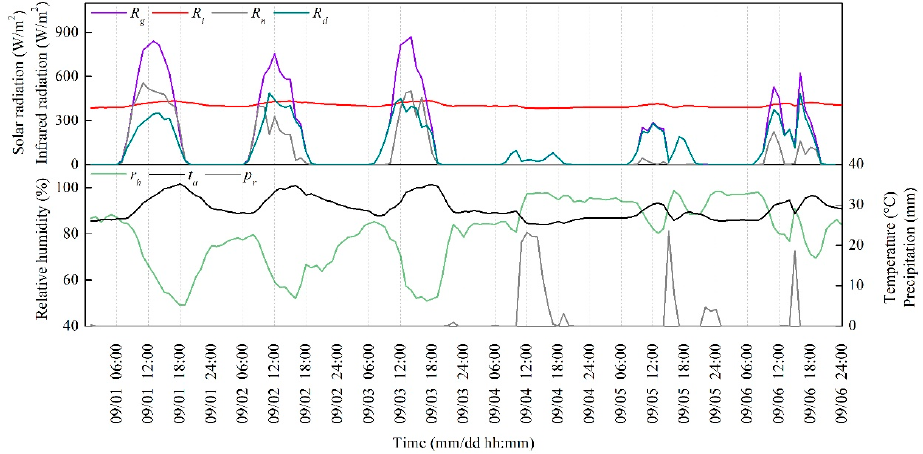
Figure 4. Meteorological data in the non-air-conditioning experimental conditions. R g : global horizontal solar radiation; R i : horizontal infrared radiation intensity from the sky; R n : direct normal solar radiation; R d : diffuse horizontal solar radiation; r h : relative humidity; t a : air temperature; and p r : precipitation.